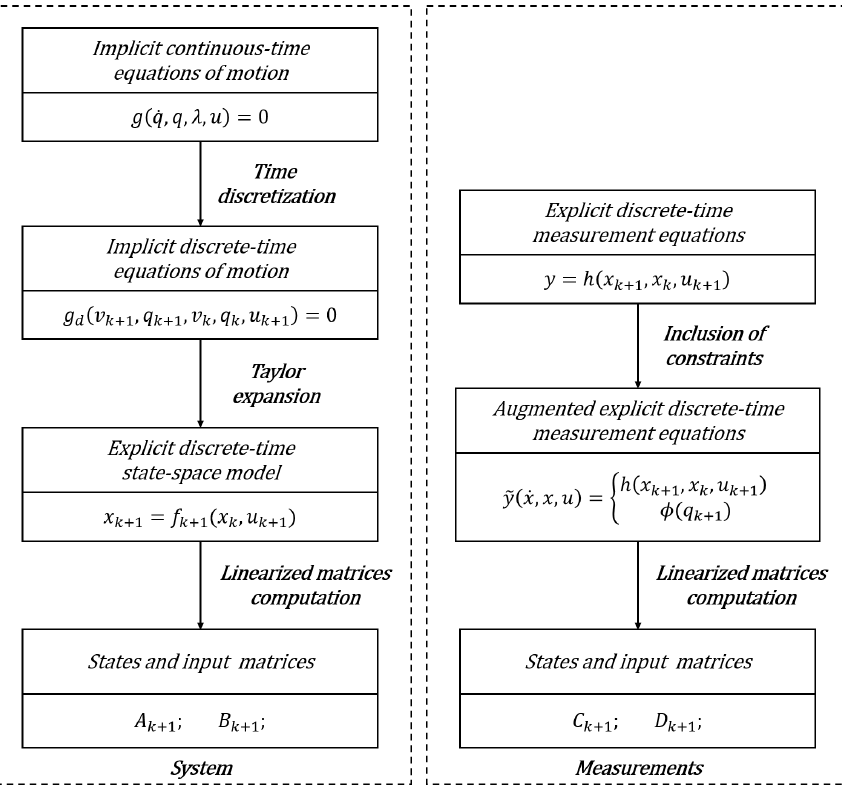
Figure 1. Block diagram representation of the system and measurement matrices computation for a generic integration